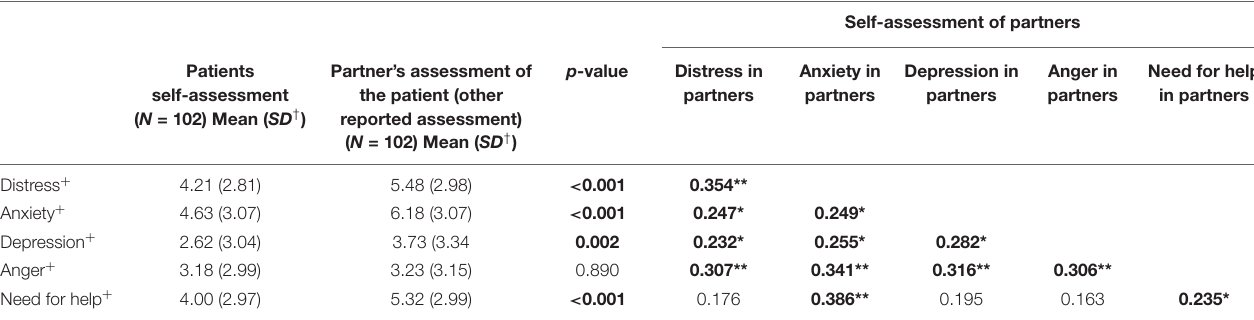
TABLE 3 | Associations between male partners’ assessment of female patients’ mental burden (other reported assessment) and needs and patients self-assessment of mental burden and needs (Pearson’s correlation).